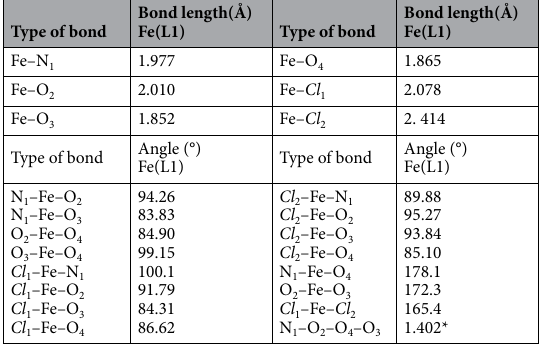
Table 6. The optimized bond lengths (Å) and bond angles (°) of [Fe(L1)(H 2 O) 2 Cl 2 ]. • dihedral angle.